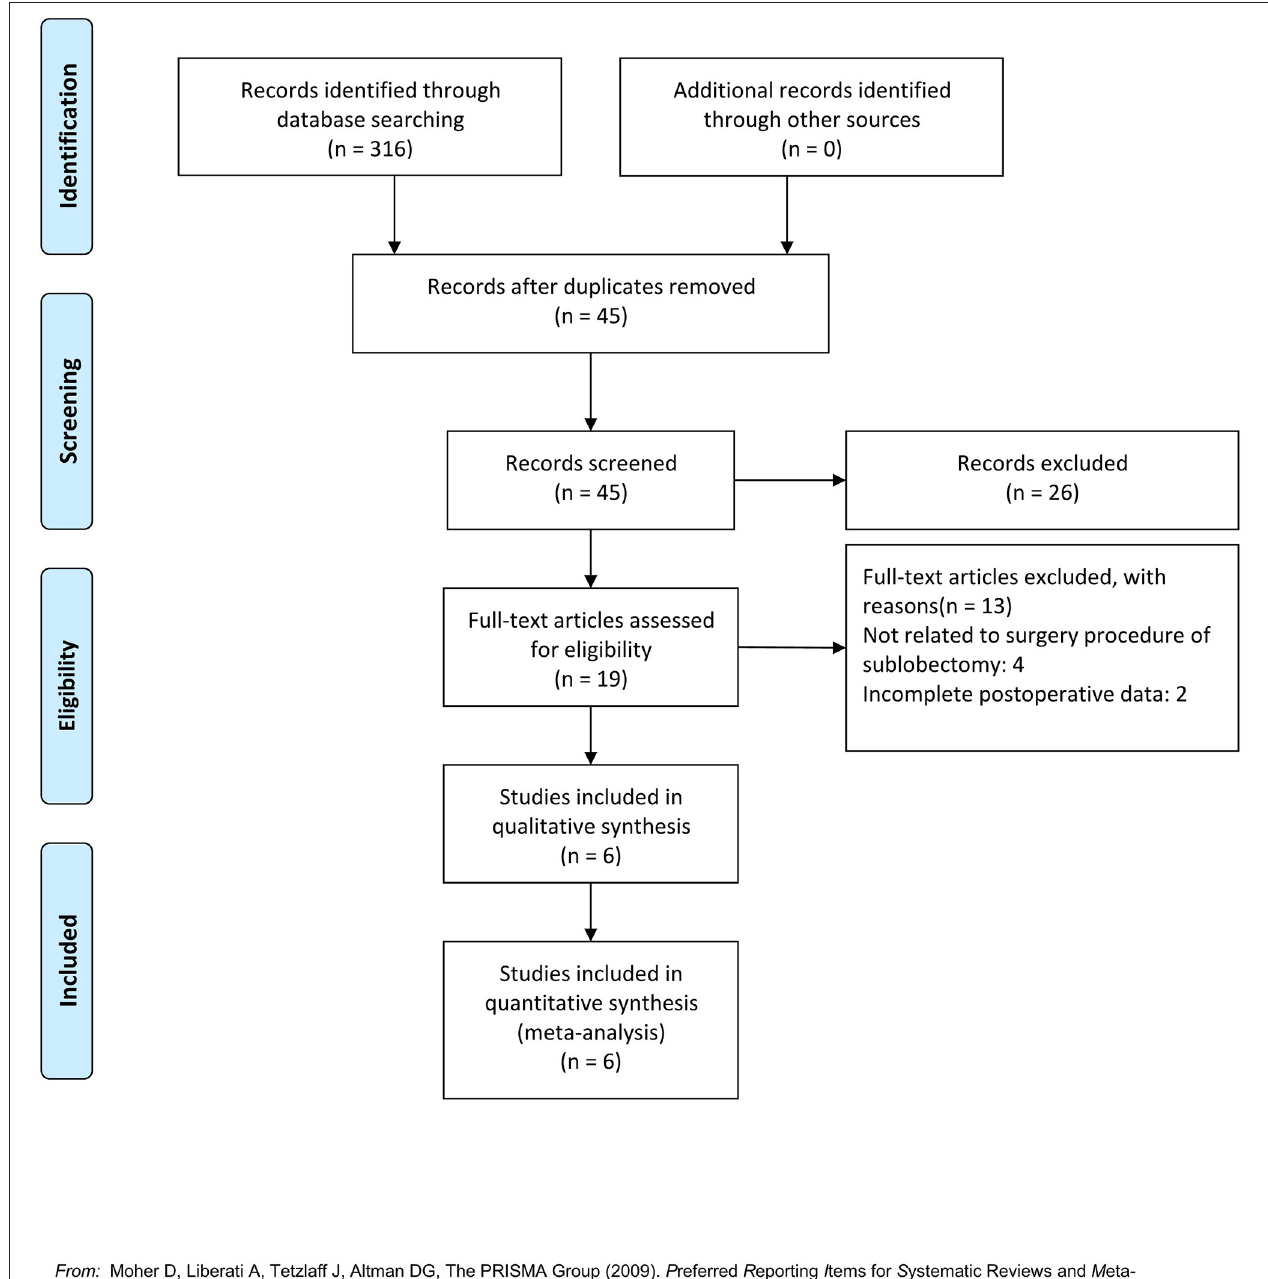
FIGURE 1 | Flowchart of the study search and selection.